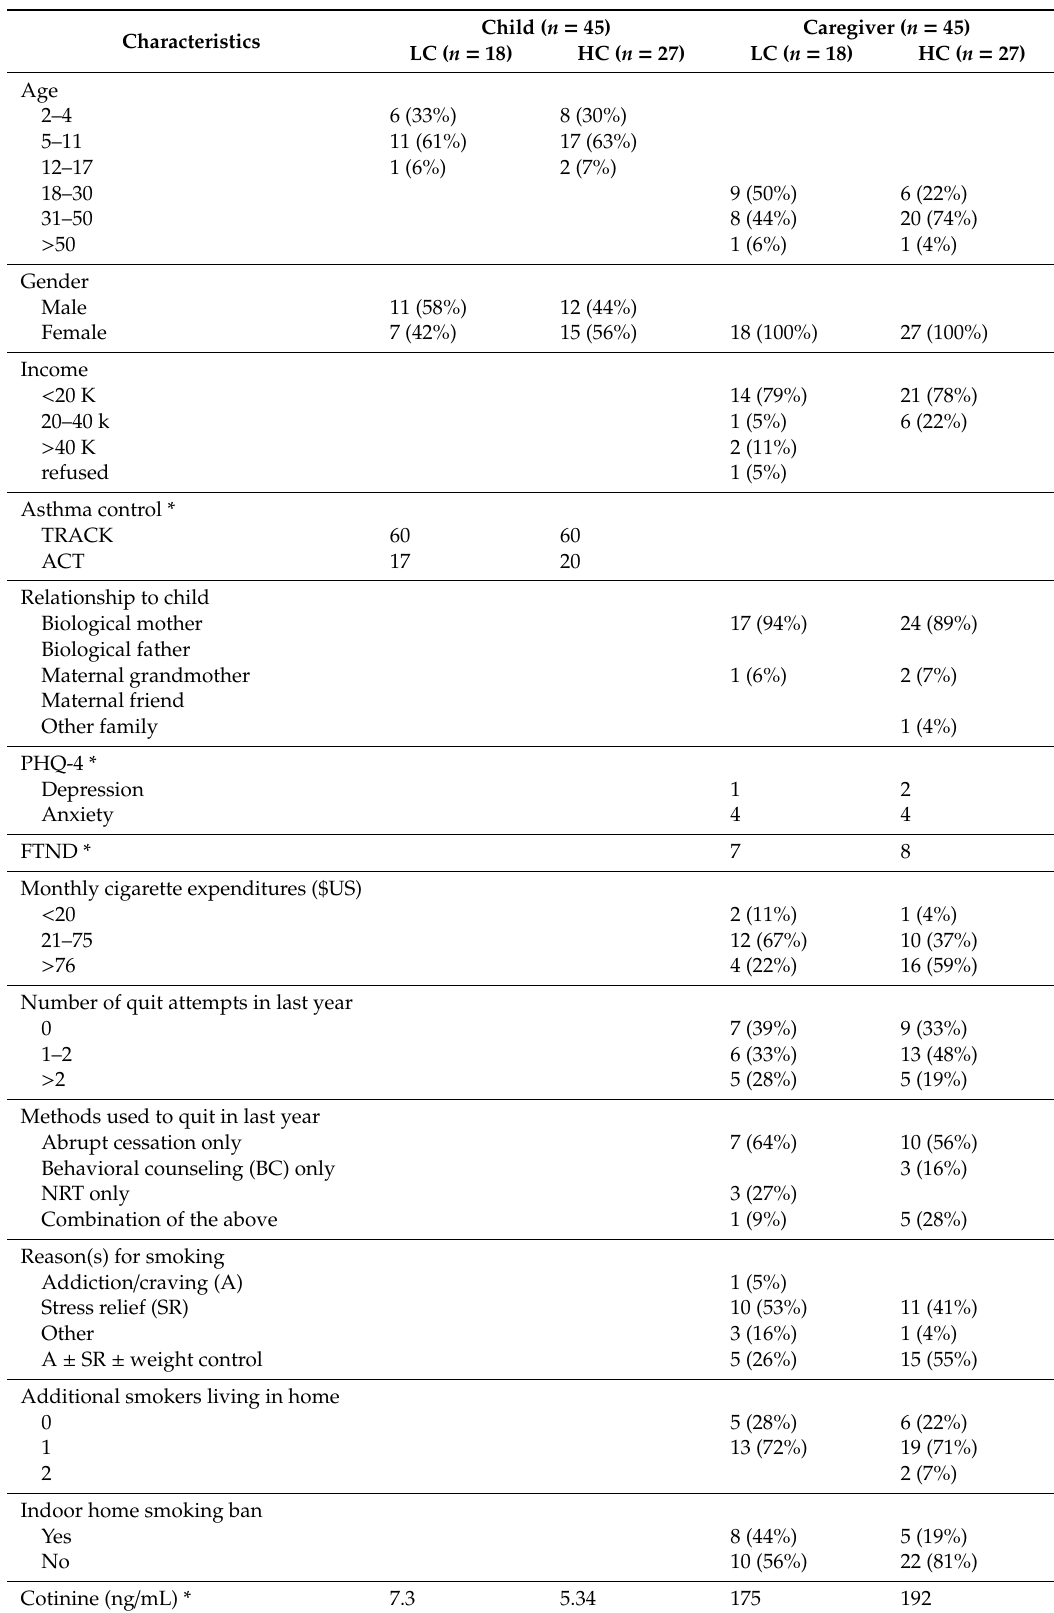
Table 1. Baseline characteristics of study participants ( n =